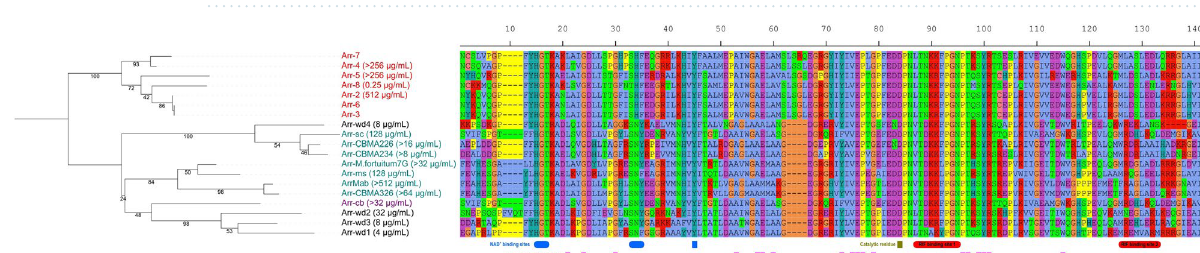
Figure 3. Arr phylogenetic tree and sequence alignment. The colored labels indicate the phyla of the organisms from which the sequences were obtained: red, Proteobacteria ; aqua, Actinobacteria ; purple, Firmicutes ; black, environment. The value in parentheses corresponds to the MIC given by Arr expressed in heterologous systems. Highlighted residues are based on the clustalX color scheme. Conserved residues and motifs are shown below the alignment, as follows: NAD + binding sites, blue; catalytic residue, olive; RIF binding sites, red. Highly conserved residues (≥ 90%), considering all Arr sequences analyzed in the phylogeny, are represented below the alignment by the fuchsia blocks. References: Arr-2, Arr-sc, and Arr-ms 1 ; Arr-4 and Arr-5 6 ; Arr-8 8 ; Arr-w1, Arr- w2, Arr-w3, and Arr-w4 4 ; ArrMab 7 ; Arr-cb 2